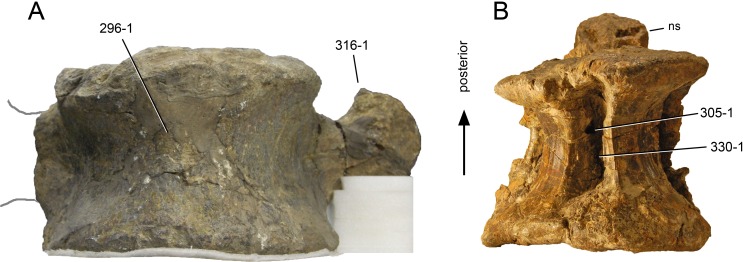
Diplodocid anterior caudal vertebrae.Anterior caudal vertebrae of Apatosaurus ajax YPM 1860 (A) and Diplodocus sp. DMNS 462 (B) in ventral view. Note the ventral keel (A; C296-1), the ventral foramen (B; C305-1) within the ventral longitudinal hollow (B; C330-1), and the anteroposteriorly expanded distal end of the transverse process (A; C316-1). Abb.: ns, neural spine. Scaled to same centrum length.